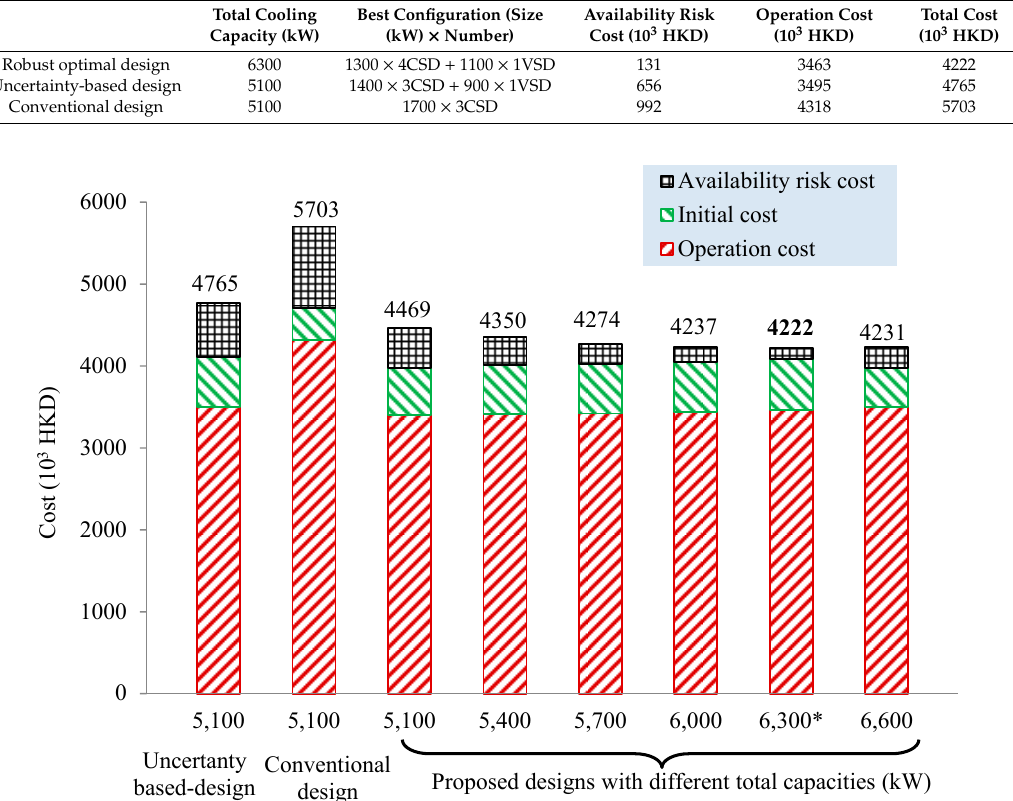
Figure 10. The costs of the optimum configurations using different design methods.